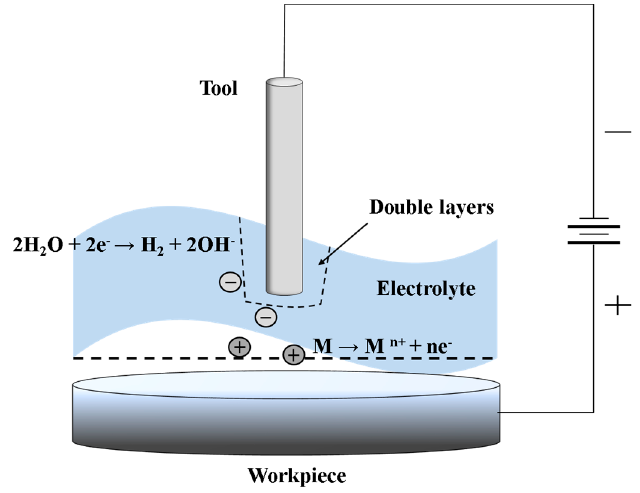
Figure 4. Principle of the electrochemical machining (ECM) process.